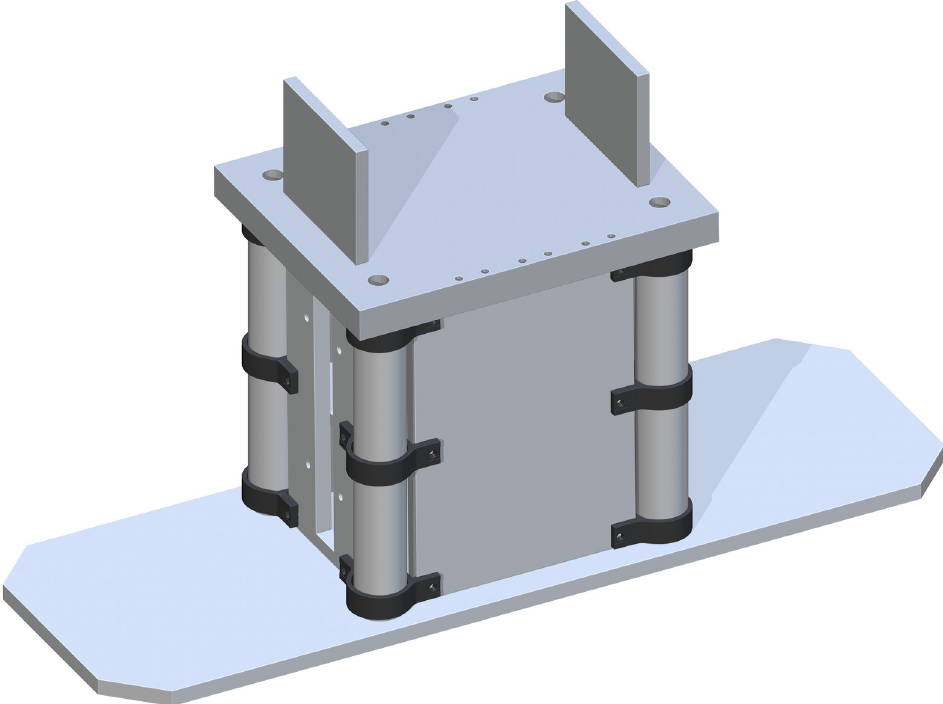
Fig 7. Completing the base support structure by adding the Top Support